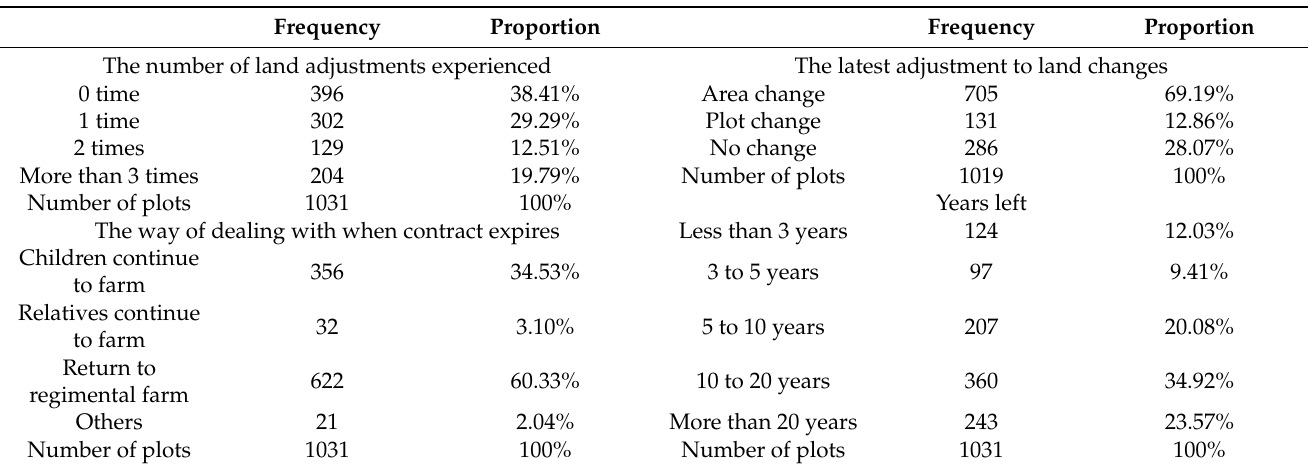
Table 1. Description of land adjustment and land